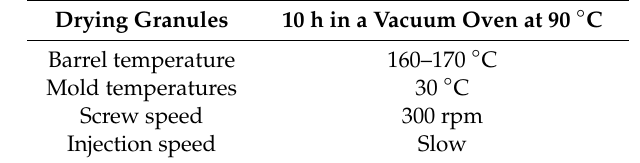
Figure 1. Workflow to produce bio-composites particulate based on polylactic acid (PLA) and natural waste. Table 2. Injection parameters.